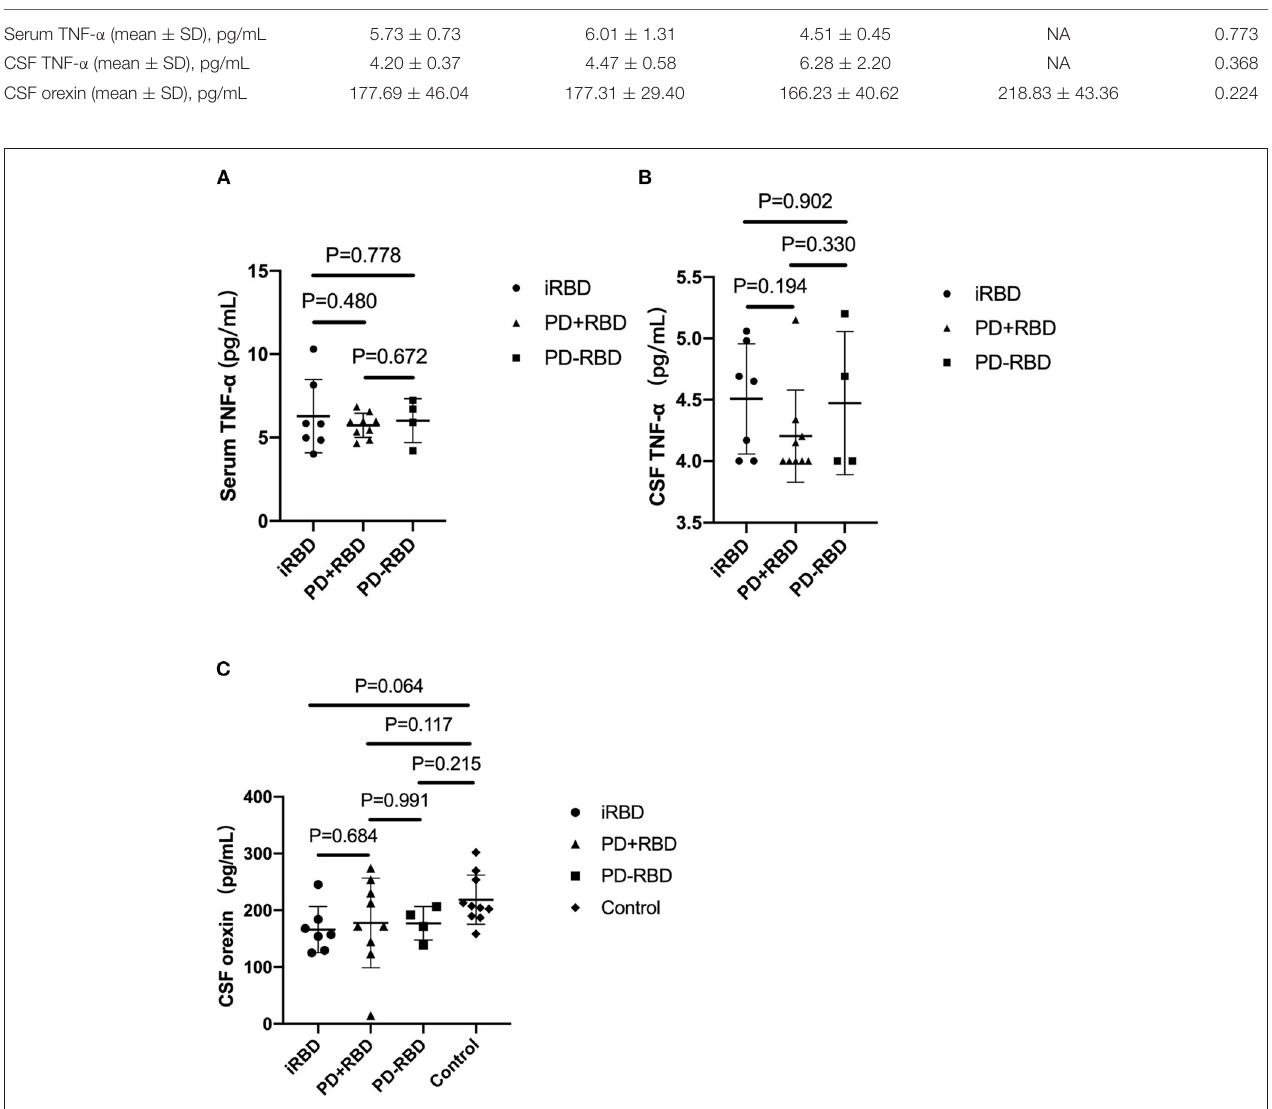
FIGURE 1 | The levels of TNF- α in serum and cerebrospinal fluid (CSF) in PD patients with RBD, PD patients without RBD, and isolated RBD patients (A,B) . The levels of orexin in CSF in the four groups (C) . Bars represent the mean values, and T bars indicate the standard deviations.